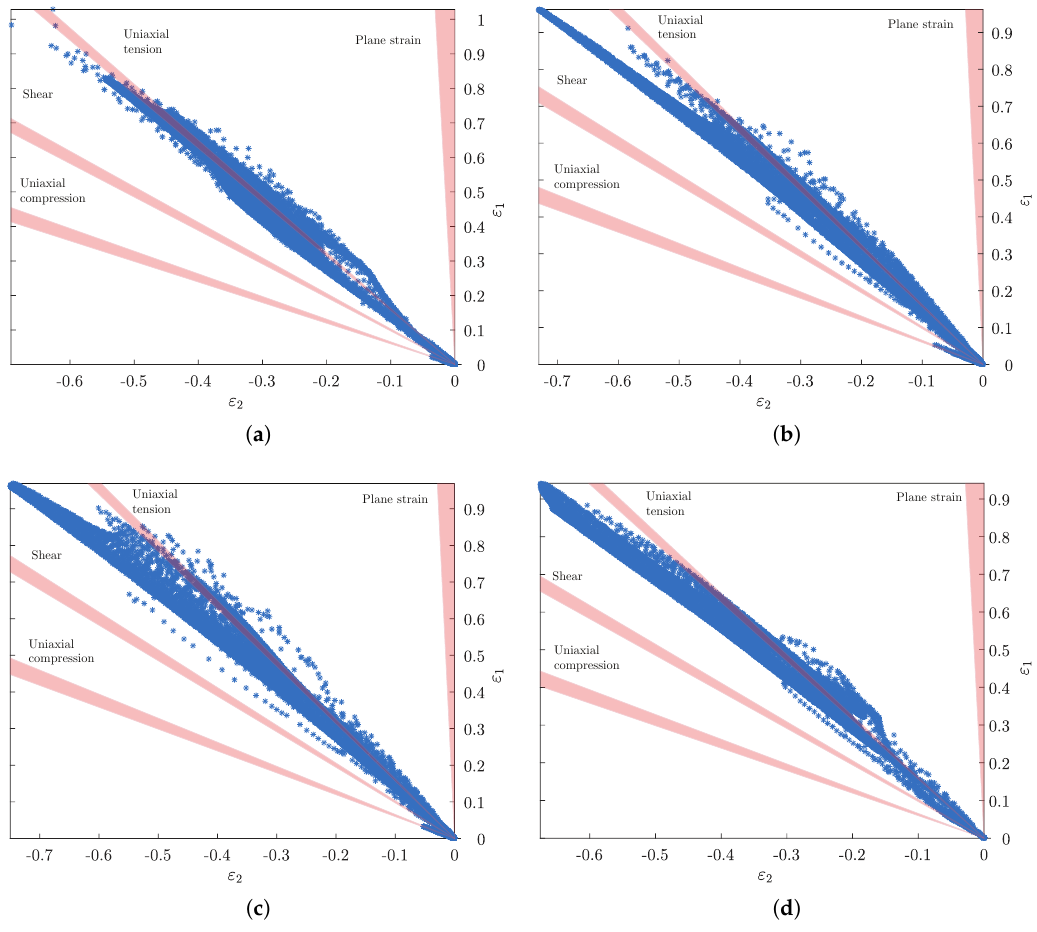
Figure 7. Range of ε 2 / ε 1 values on the specimen surface corresponding to the last stage of the test. ( a ) CMA-ES and ( b ) SDBOX with B-splines; ( c ) CMA-ES and ( d ) SDBOX with